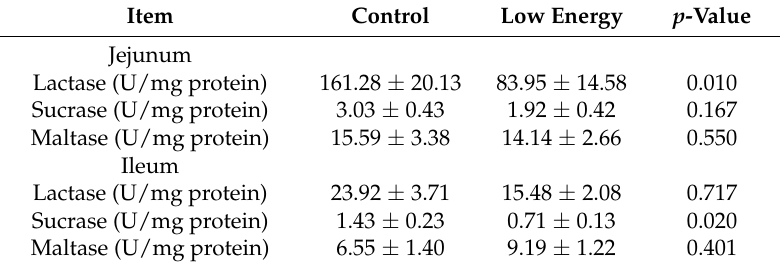
Table 7. Effect of different energy levels during gestation on intestinal enzyme activity in newborn